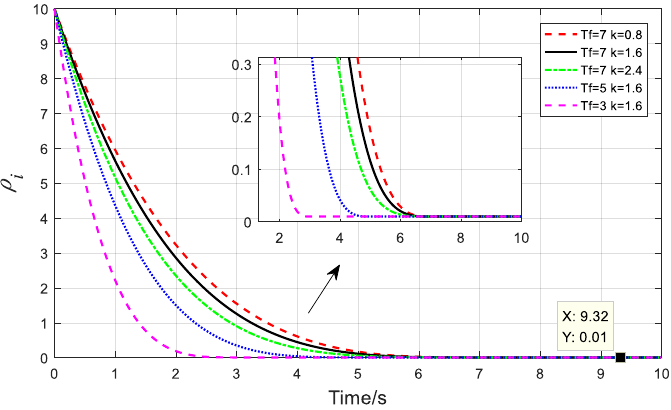
Figure 2. The simulation results with different f T and k .